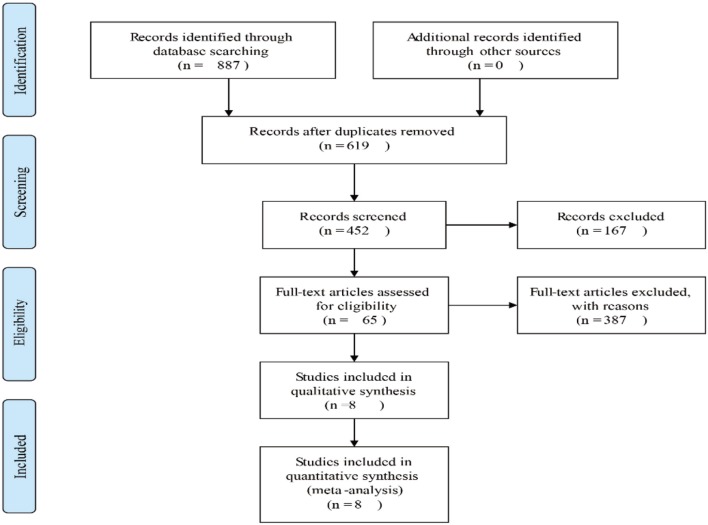
Flow diagram of the study selection in this meta-analysis.